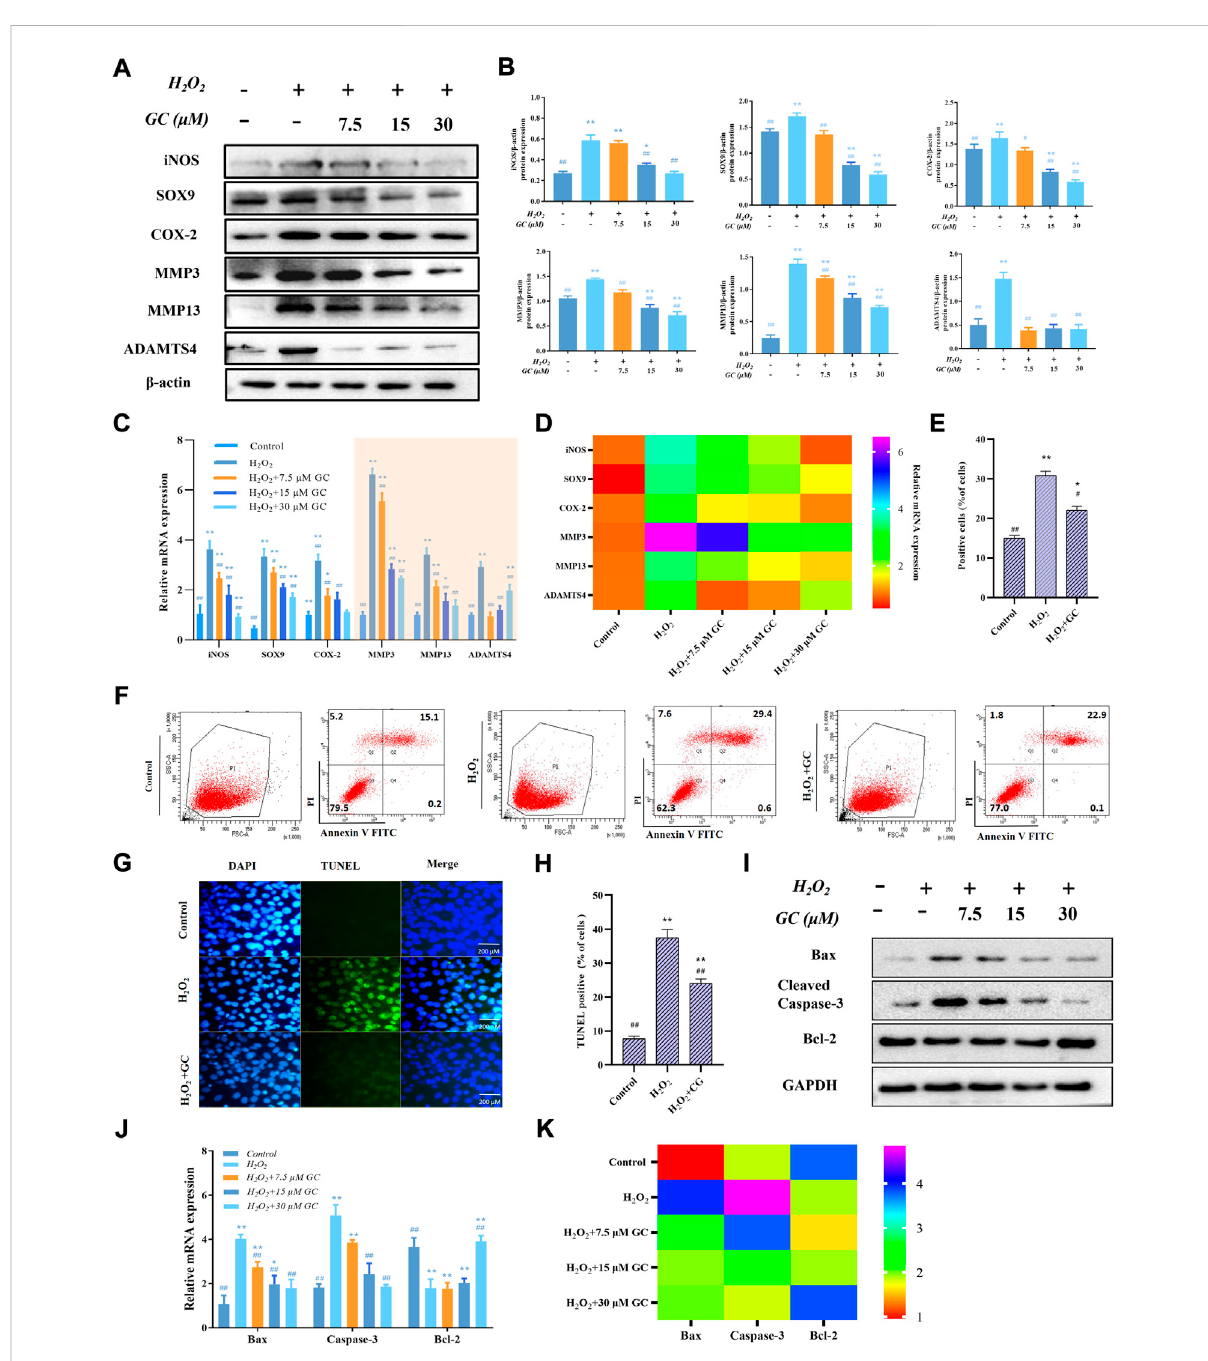
FIGURE 2 GC inhibits H 2 O 2 -induced chondrocyte apoptosis and cartilage degradation. (A) By using a western blot, it was possible to identify the protein expression of iNOS, COX-2, SOX-9, MMP3, MMP13, and ADAMTS4 in chondrocytes that had been exposed to GC and H 2 O 2 for 24 h. (B) Using ImageJ, the related protein expression was examined. (C and D) The expression levels of certain cartilage degeneration-related genes were evaluated using qPCR. (E and F) Annexin V/PI detected GC on H 2 O 2 -induced chondrocyte apoptosis. When calculating the apoptosis rate, the sum of the apoptosis rates in the Q2 and Q4 quadrants was used, that is, the late apoptotic group + the early apoptotic group (that is, all AnnexinV positive groups, of which the Q2 quadrant was the PI staining positive group). (G) Examples of terminal deoxynucleotidyl transferase-positive, deoxyuridine triphosphate nick end-labeled nuclei (green color). 200 µm scale bar. (H) Percentages of TUNEL-positive cells relative to total cells. (I) Western blotanalysiswasusedto identifytheproteinexpression ofCleved-caspase3,Bax,and Bcl-2inchondrocytesco-appliedwithGCandH 2 O 2 for 24 h (J and K) The expression levels of certain apoptosis-related genes were evaluated using qPCR. All data are presented as mean ± SD (n = 3). * p < 0.05 and ** p < 0.01 vs. control group; # p < 0.05 and ## p < 0.01 vs. H 2 O 2